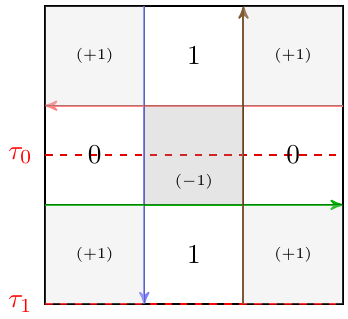
Figure 6b. The five-brane diagram of the conifold C with the fixed lines of the Ω pro-